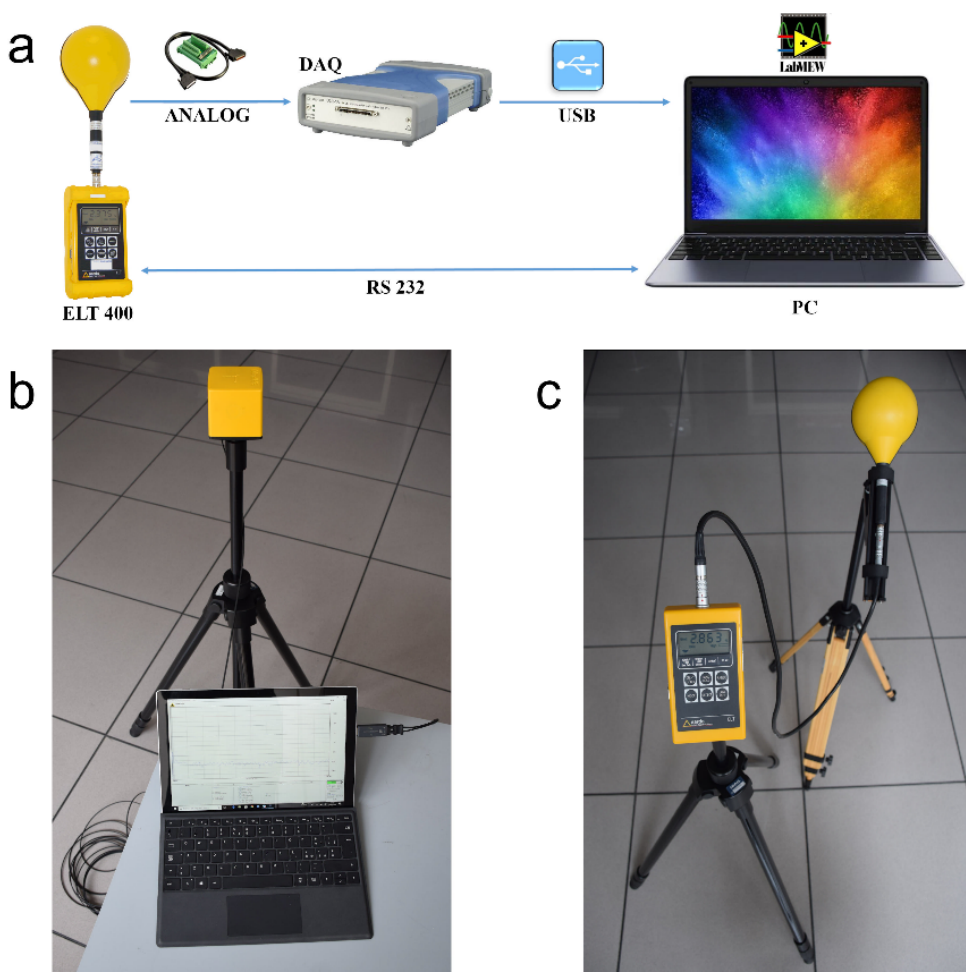
Figure 2. Instrumental chains for GFM measurement: ( a ) Narda ELT-400 with acquisition system; ( b ) Narda ELT-400 in a stand-alone version; ( c ) Narda-PMM EHP-50F.